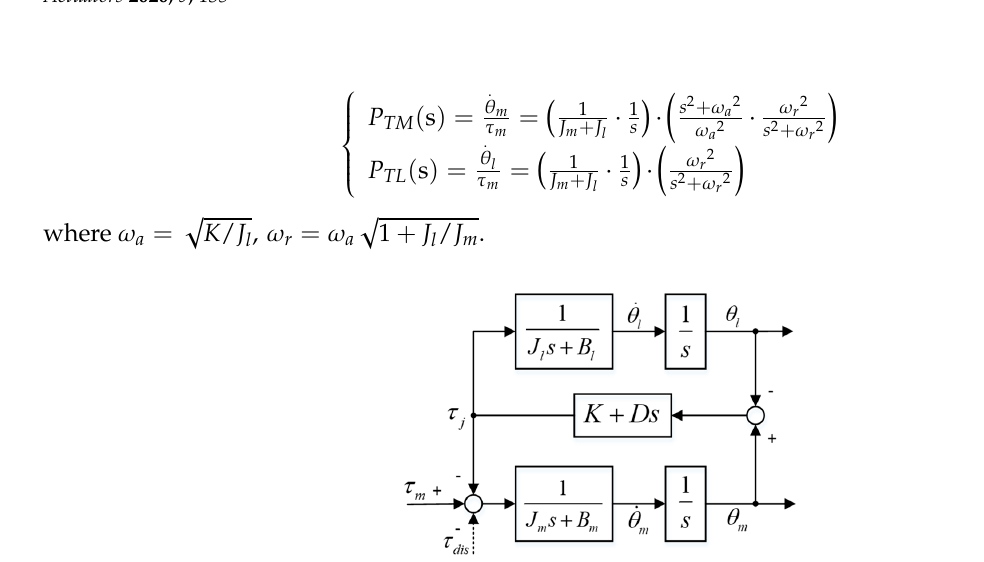
Figure 3. Modular drive joint frequency responses: ( a ) from In Figure 3, the black lines are acquired by actual measurement data of the experiment. The red